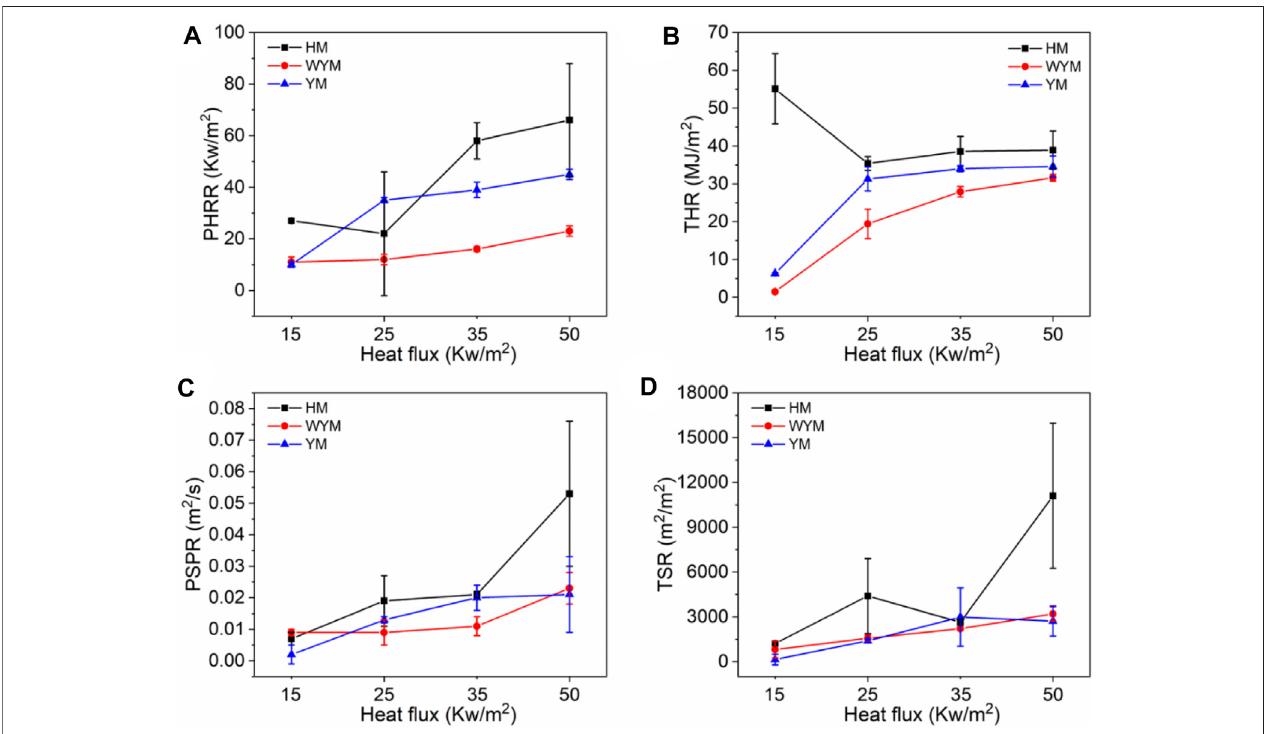
FIGURE 17 | Variation trend of heat and smoke: (A) PHRR, (B) THR, (C) PSPR, and (D) TSR.